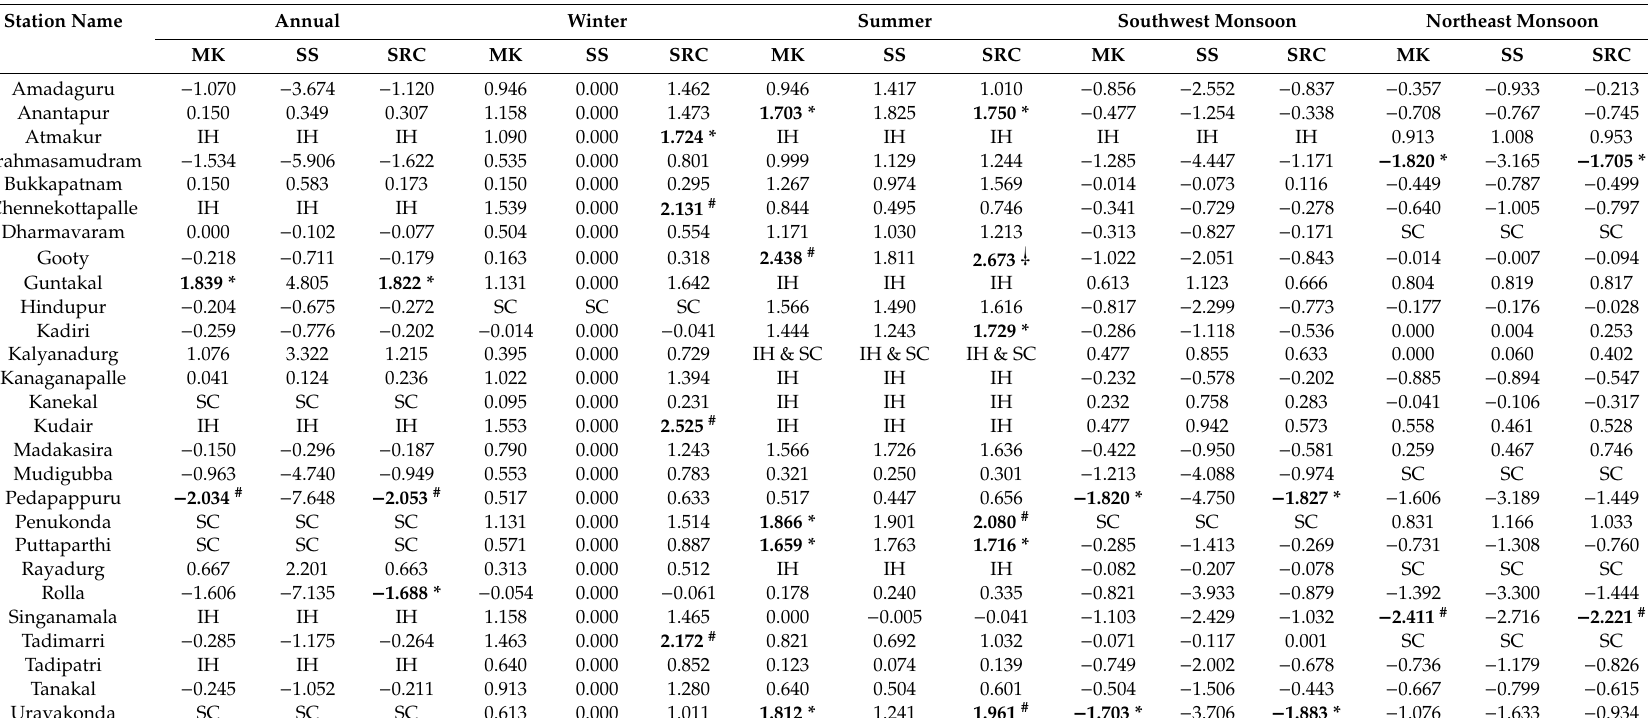
Table 3. Results of the Mann–Kendall (MK) test, Sen’s Slope test (SS), and Spearman’s rank correlation coe ffi cient (SRC) test without considering the e ff ect of serial correlation.